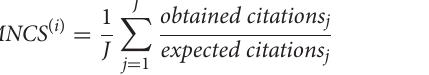
MNCS for selected OECD countries 3 in the upper left panel in Figure 2 . In general the MNCS is steadily improving for